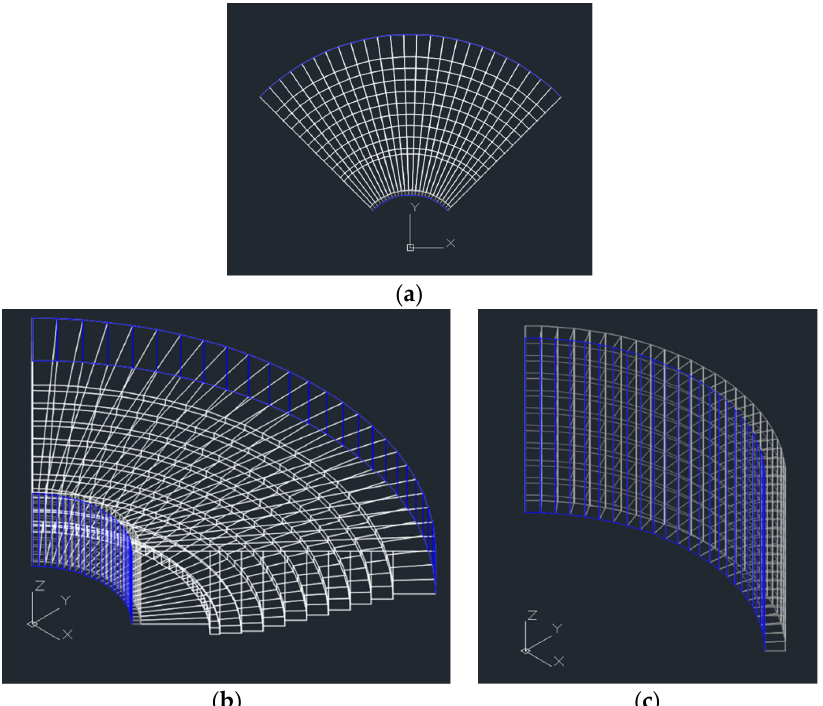
Figure 11. Virtual auditorium developed in Case C. ( a ) Top view of the auditorium and the semi- circular DSF, ( b ) tri-dimensional southeast view of the auditorium and the semi-circular DSF, and ( c ) tri-dimensional southeast view of the semi-circular DSF.